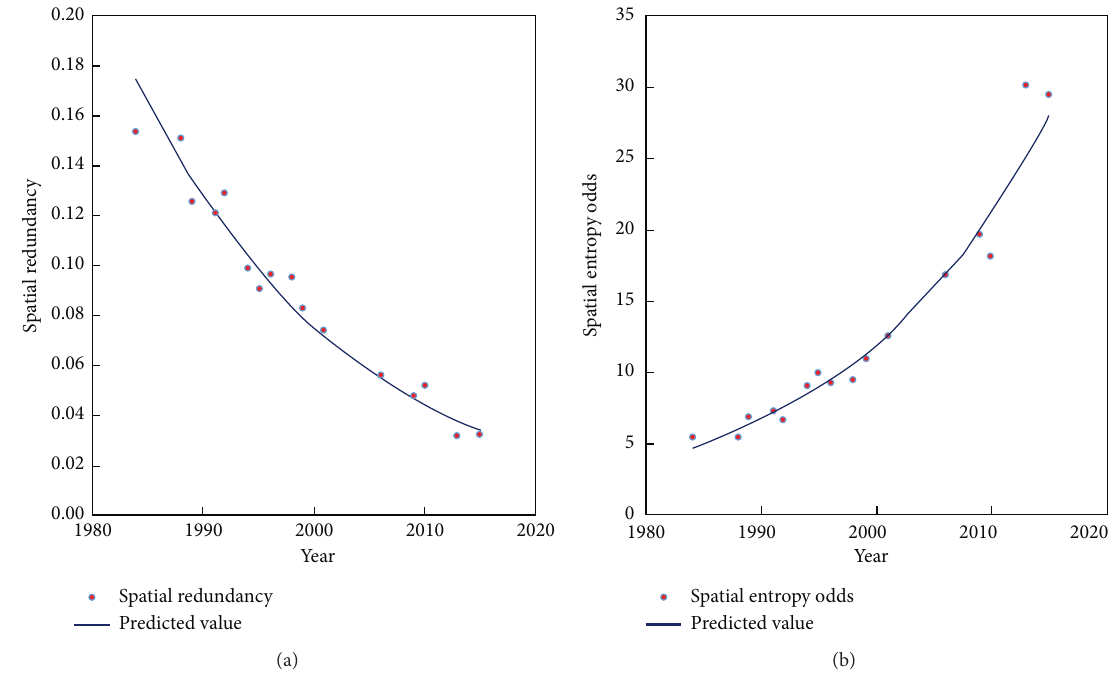
Figure 4: The spatial redundancy and spatial entropy odds of Beijing’s urban form and growth (1984–2015). (a) Spatial redundancy. (b) Spatial entropy